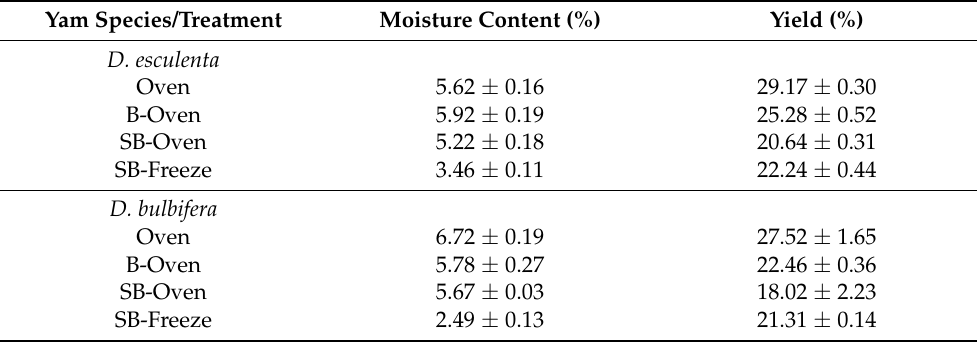
Table 2. Yield and moisture content of yam flour prepared with different processing